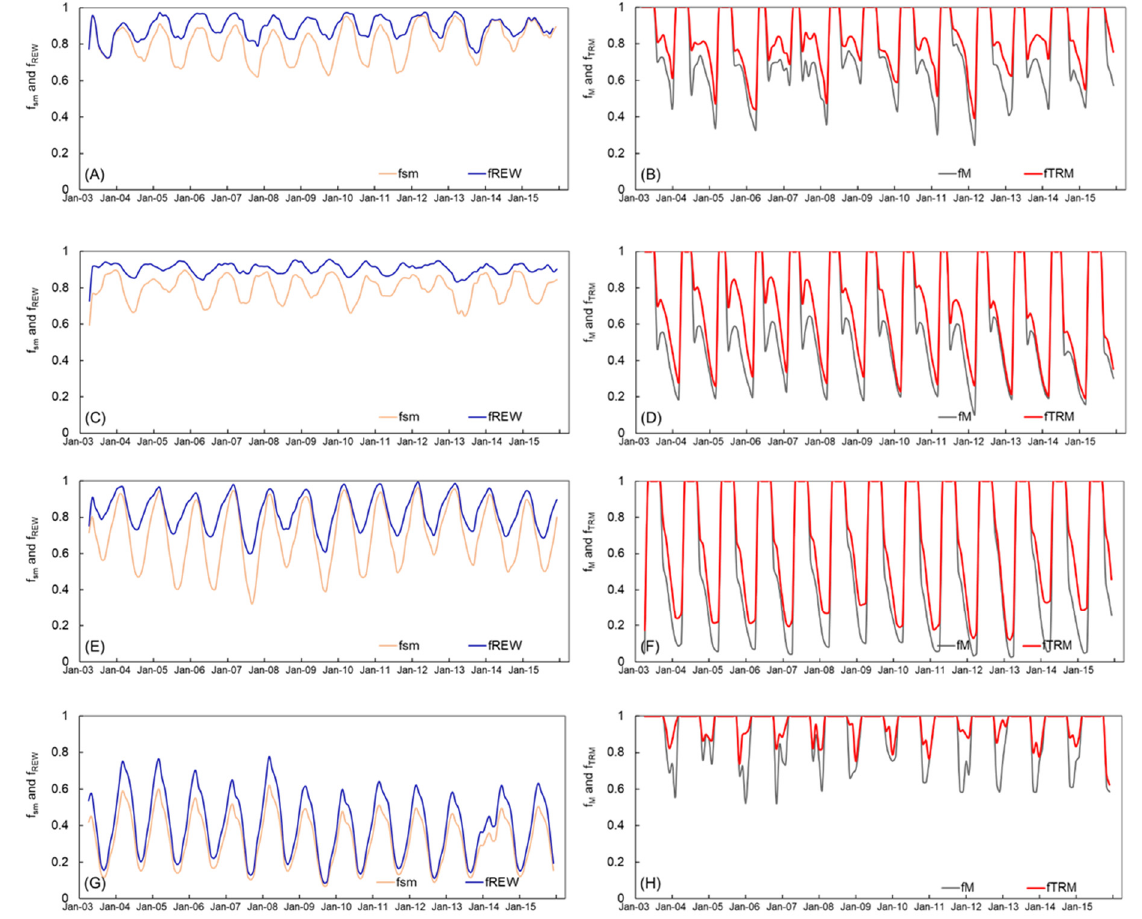
Figure 4. Comparisons of smoothed f sm and relative extractable water ( f REW ), f M and new soil water availability constraint on transpiration ( f TRM ) during 2003.1–2015.12 at ( A , B ) CN–Qia (forest) flux tower, ( C , D ) CN–Ha2 (shrub) flux tower, ( E , F ) CN–Du2 (grass) flux tower, and ( G , H ) YC (crop) flux tower.